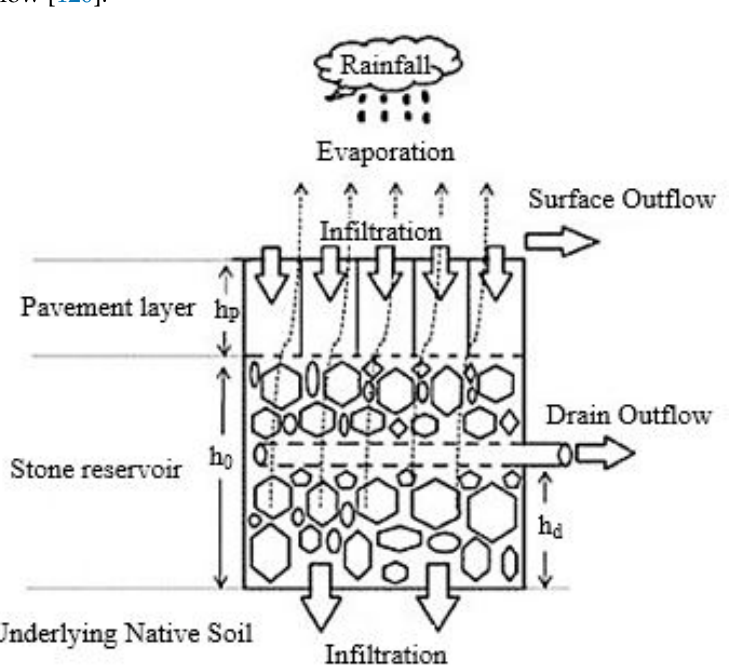
Figure 9. Cross-section of a typical permeable pavement (Modified after Zhang et al.) [67].